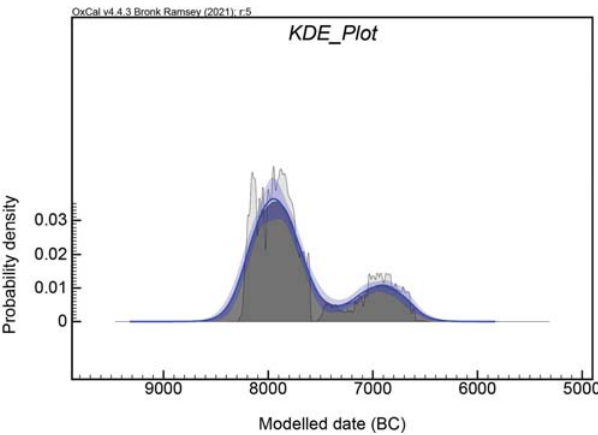
Figure 5: KDE - plot of all dates from the InterCity - sites and Pjonkerød show a bimodal distribution re fl ecting the chronological distribution of dated events and main activities at the sites. A model = 100, A overall = 99.3. For data see Supplementary